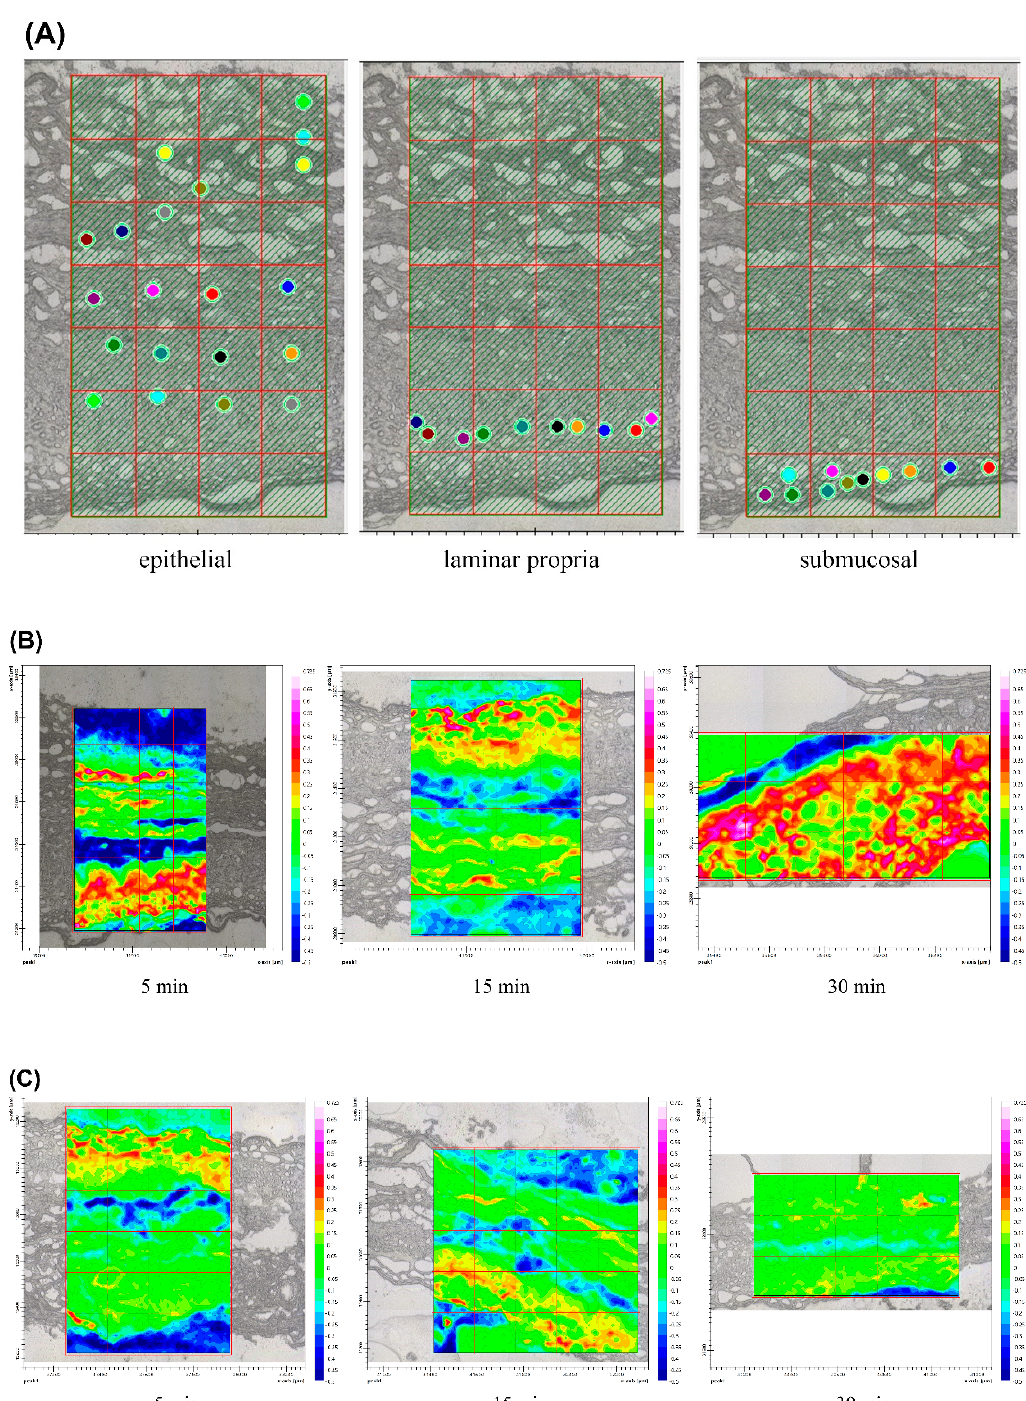
Figure 7. Ex vivo permeation results obtained from the FPA IR images of the epithelial, laminar propria, and submucosa layer of the microtome cross-sectioned barrier membrane, as follows: ( A ) 2D image at initial (blank porcine esophagus), ( B ) 2D image by ATR-FTIR at 5 min, 15 min, and 30 min of cross section of porcine esophagus exposed to FPM7 ( C ) compared to FPM8. FPA FTIR imaging of tissue samples exposed to FPM7 (Figure 8A) and FPM8 (Figure 8B) showed the epithelial, lamina propria, and submucosal layers of the microtome cross- sectioned barrier membrane as blank esophagus (red line) and FA powder (grey line). They were exposed to FPMs for 5 min (blue line), 15 min (pink line), and 30 min (green